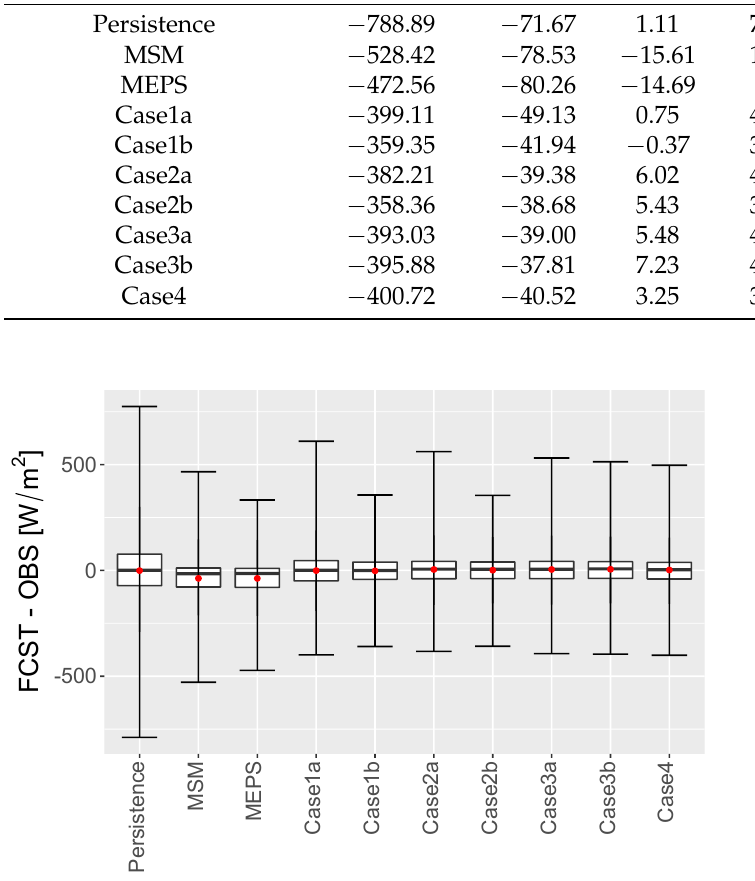
Figure 8. Box plot of the forecast error in total. Note that red point and black line indicate MBE and median of the error.